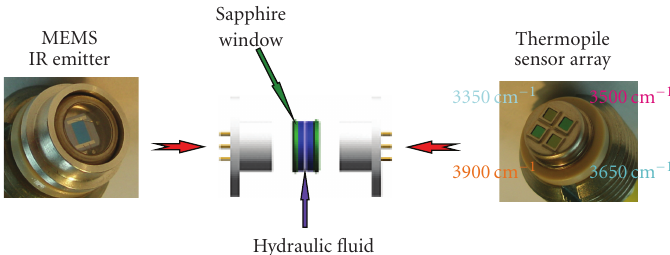
Figure 8: Schematics of IR detection system consisting of an MEMS-based IR emitter (left), an optical path (middle) and a 4-thermopile IR sensor array (right).